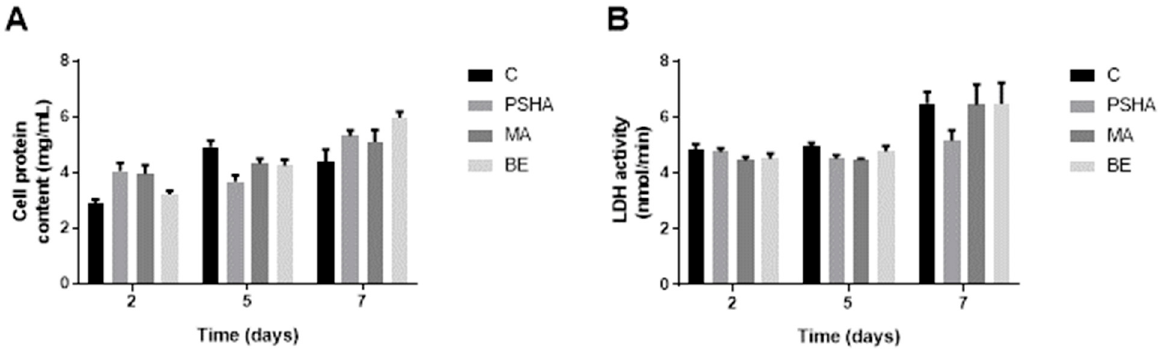
Figure 5. Estimation of total cell density by total protein content ( A ) and LDH enzyme activity ( B ) and total protein after membrane solubilization. No significant difference was found between groups ( p > 0.05), but growth over time was significantly different at 7 days ( p < 0.05). Bars indicate mean ± SEM of three independent tests with five biological replicates each.